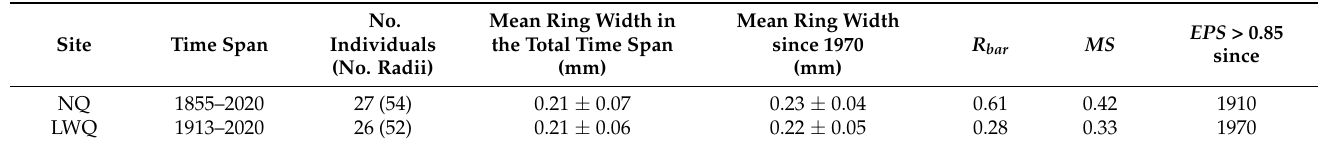
Table 1. Statistics of ring-width chronologies for the R. przewalskii shrub on the eastern TP. Abbreviations: R bar (mean inter-series correlation), MS (mean sensitivity), EPS (expressed population signal).